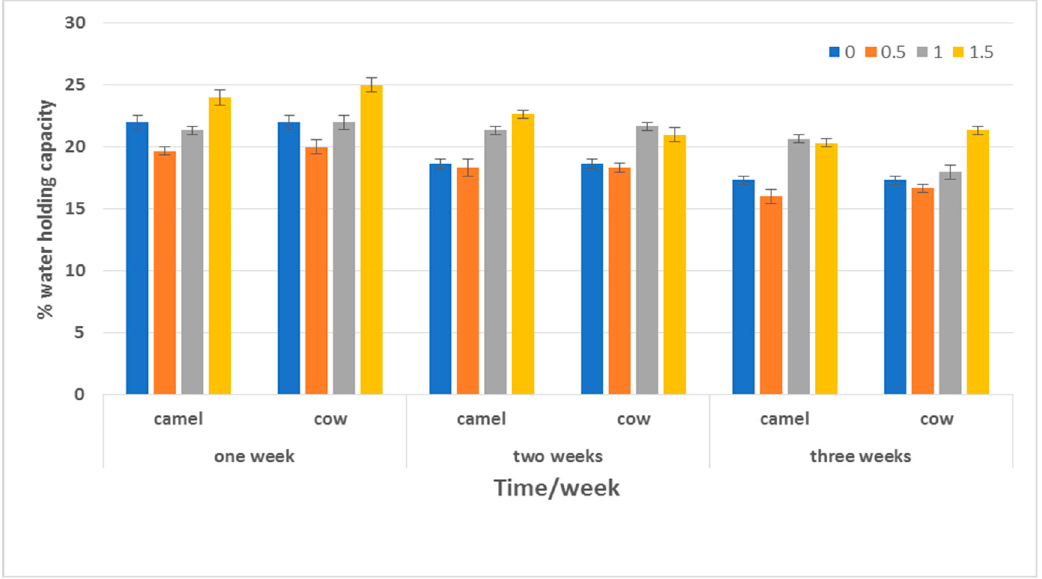
Figure 6. Changes in water-holding capacity of yoghurt made with addition of casein hydrolysates during